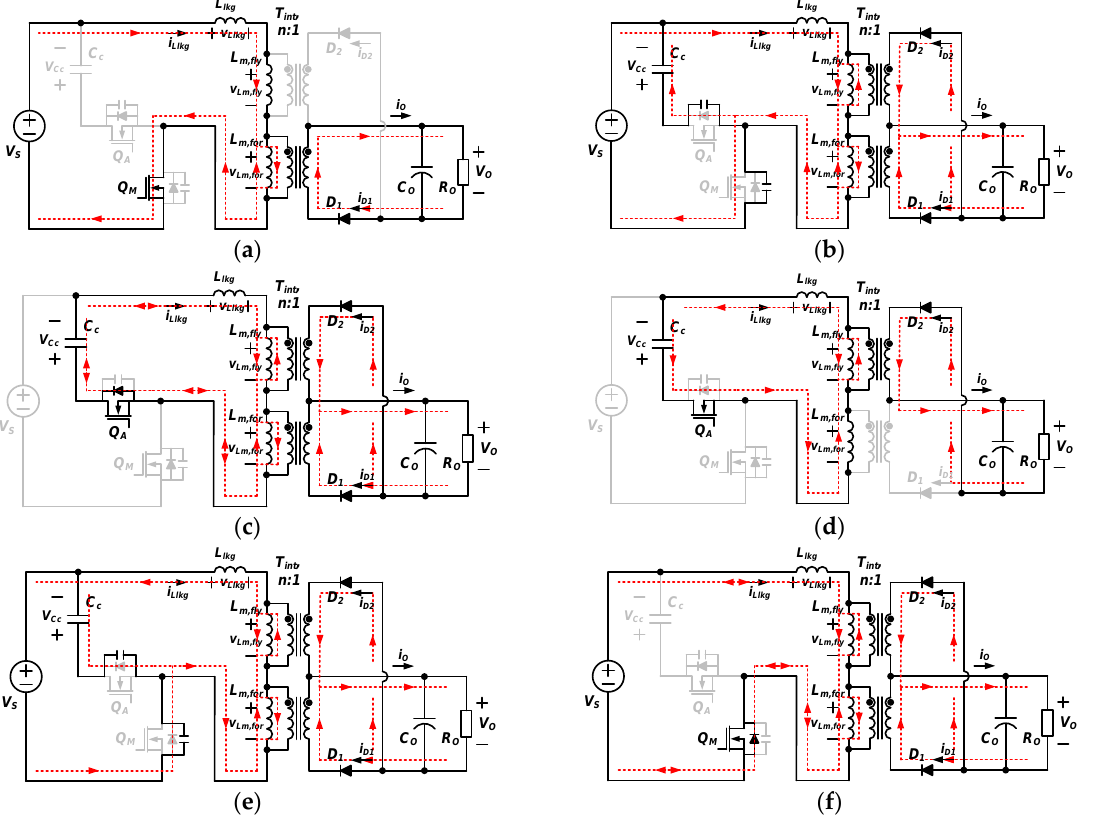
Figure 6. Topological states of ACFF converter: ( a ) Mode1 ( t 0 – t 1 ). ( b ) Mode2 ( t 1 – t 2 ). ( c ) Mode3 ( t 2 – t 3 ). ( d ) Mode4 ( t 3 – t 4 ). ( e ) Mode5 ( t 4 – t 5 ). ( f ) Mode6 ( t 5 – t 0′ ).